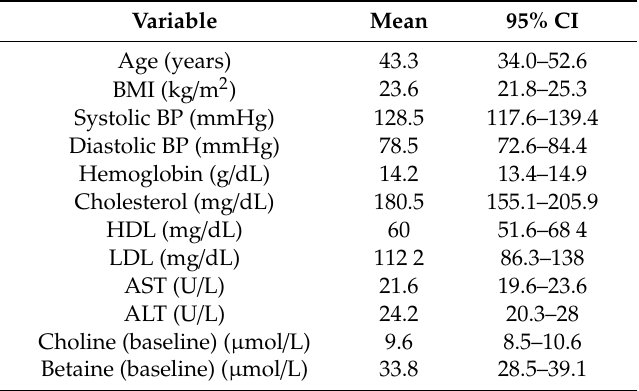
Table 1. Demographic and baseline data of the study